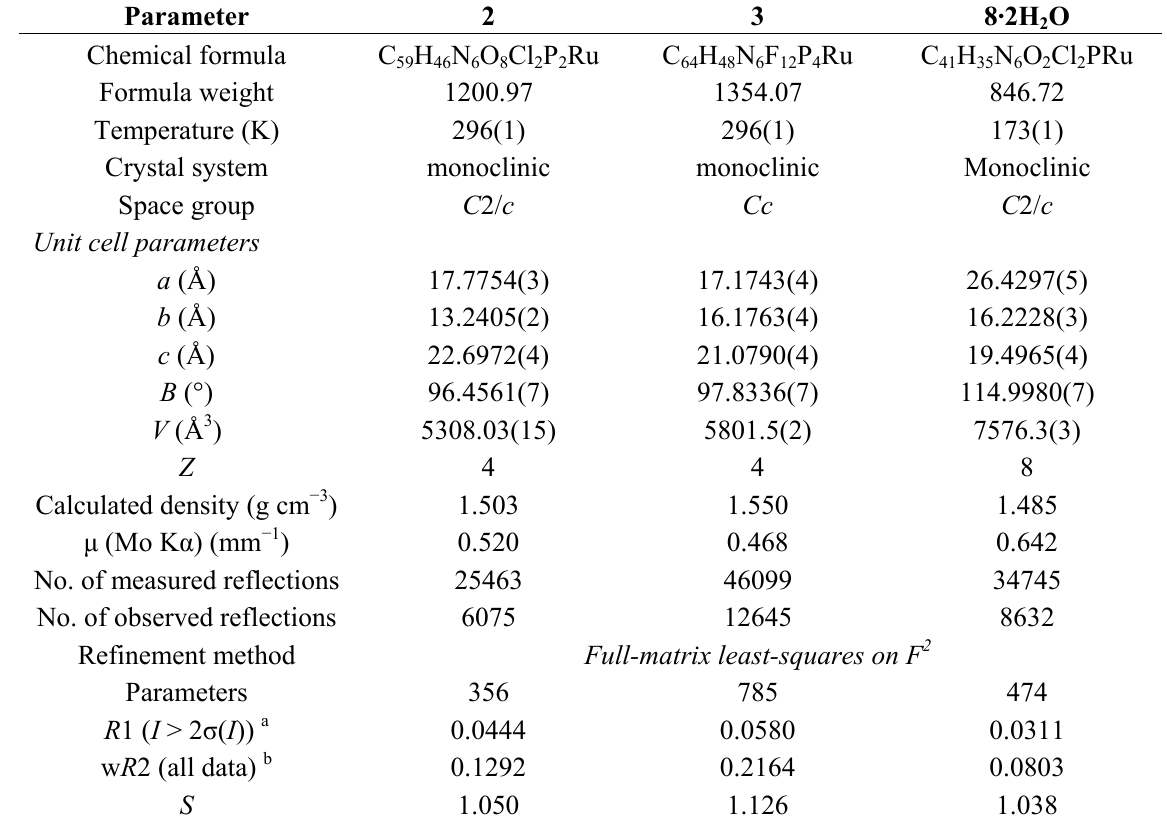
Table 3. Crystallographic data for 2 , 3 , and 8 ·2H